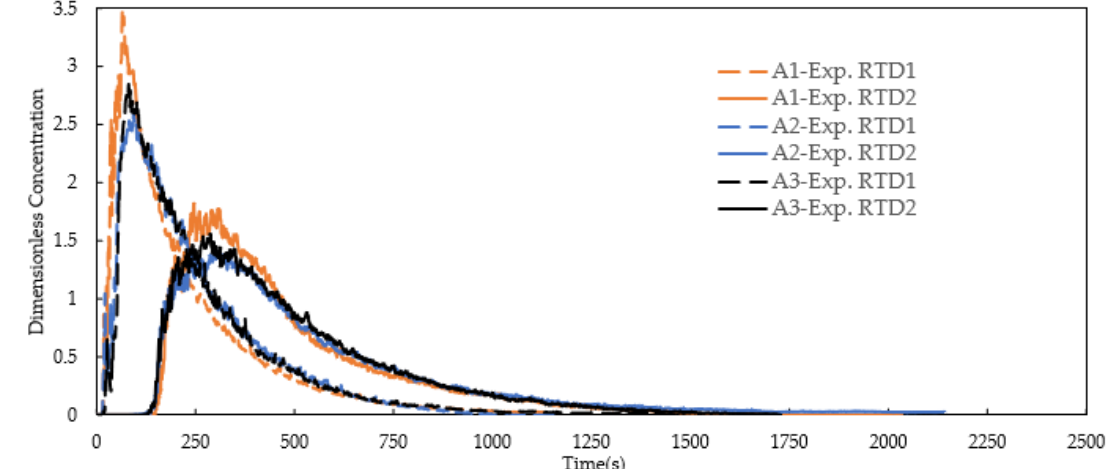
Figure 4. Measured RTD curves of Cases A1, A2 and A3.